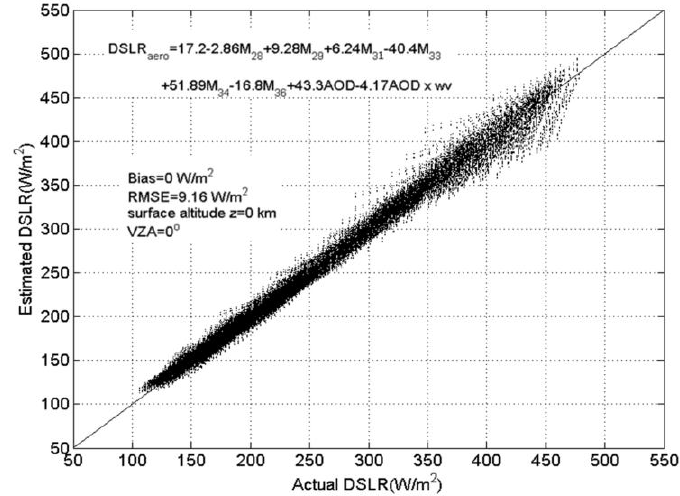
Figure 8. Comparisons of the actual downwelling surface longwave radiation with estimations using the proposed model with the training dataset and VZA = 0°, surface altitude z = 0 km and AOD less than 1.0.